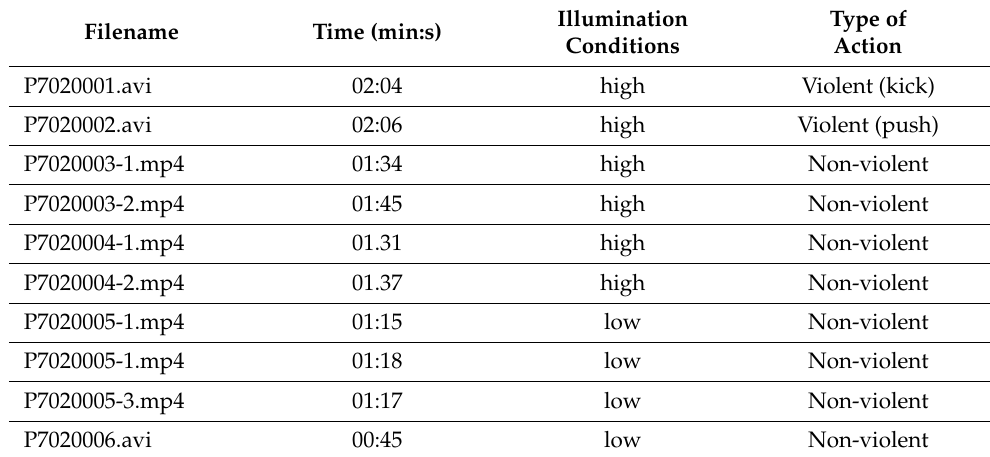
Table 2. Main characteristics of the videos contained in the DSB